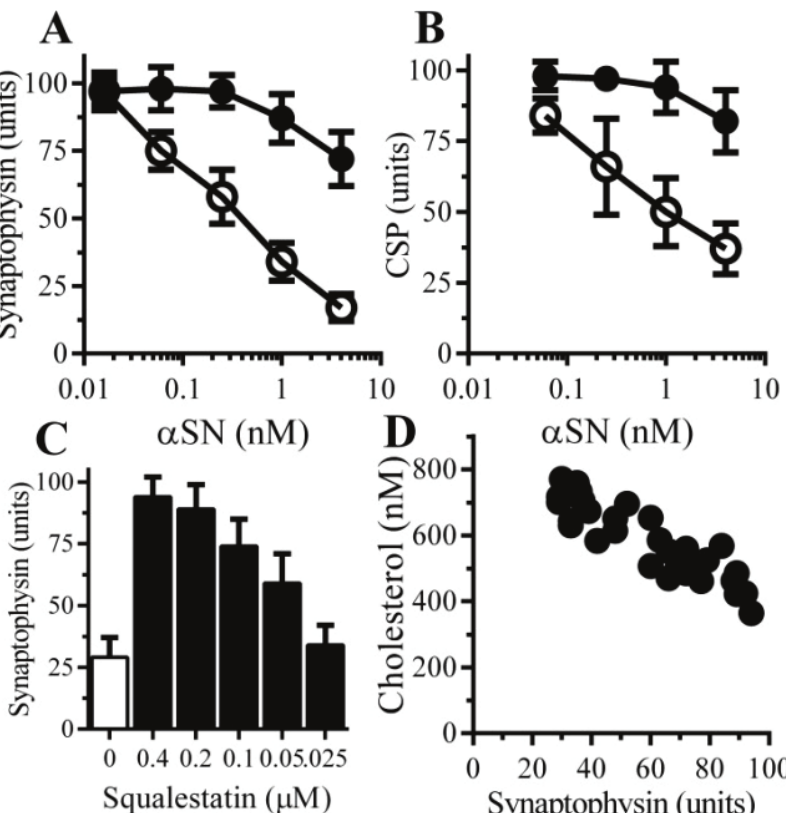
Figure 6. Squalestatin protects neurons against (cid:2)SN-induced synapse damage—The amounts of synaptophysin ( A ) and CSP ( B ) in neurons pre-treated with control medium ((cid:4)) or 200 nM squalestatin ((cid:5)) and incubated with (cid:2)SN as shown. Values are means ± SD from triplicate experiments performed three times, n = 9; ( C ) The amounts of synaptophysin in neurons pre-treated with control medium ((cid:6)) or squalestatin as shown ((cid:7)) and incubated with 1 (cid:8)M aggregated (cid:2)SN. Values are means ± SD from triplicate experiments performed three times, n = 9; ( D ) There was a significant inverse correlation between the concentrations of cholesterol in neurons treated with squalestatin (200 nM to 25 nM) and the amounts of synaptophysin in these neurons after incubation with 1(cid:8)M aggregated (cid:2)SN, Pearson’s coefficient = (cid:9)0.908, p <